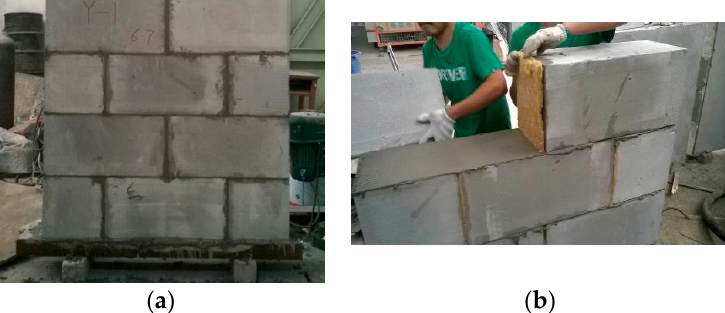
Figure 1. Construction of wall specimens: ( a ) overview; ( b ) vertical joints filled with mineral wool plate.